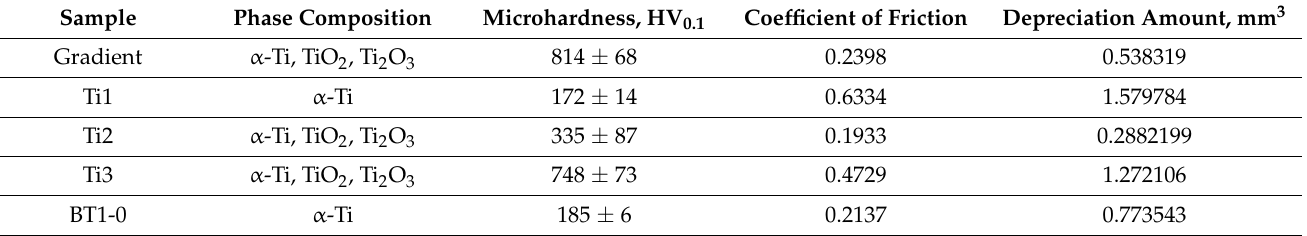
Table 5. Experimental data on the phase composition and mechanical and tribological characteristics of the coating.